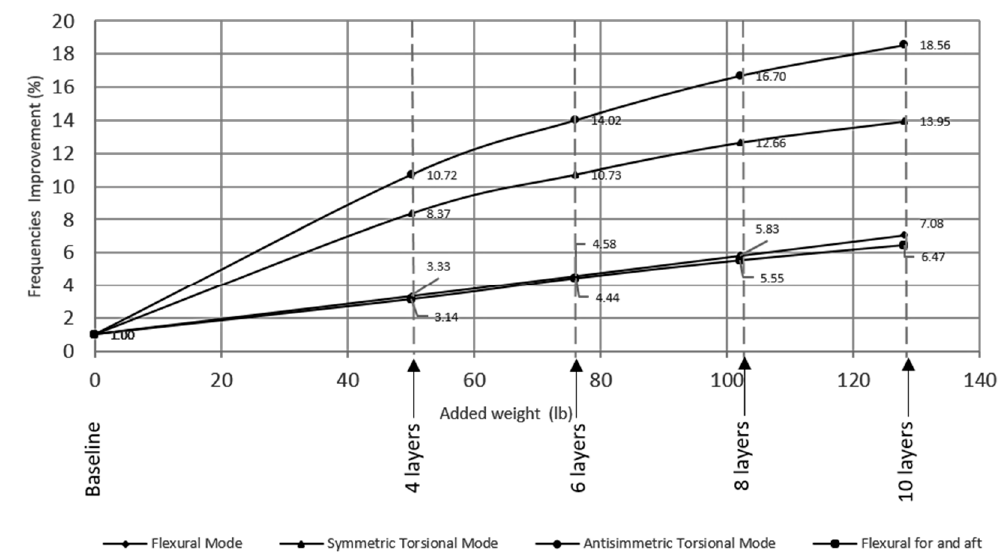
Figure 8. Airplane Mode Flexural and Torsional Frequencies vs. Added Mass .